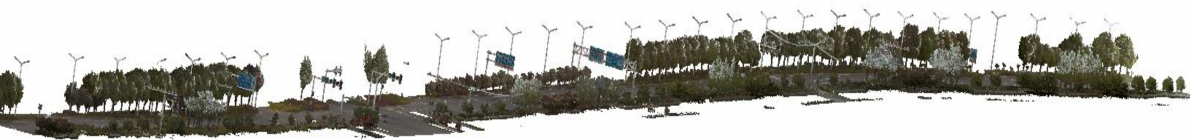
Figure 2. Road points cloud